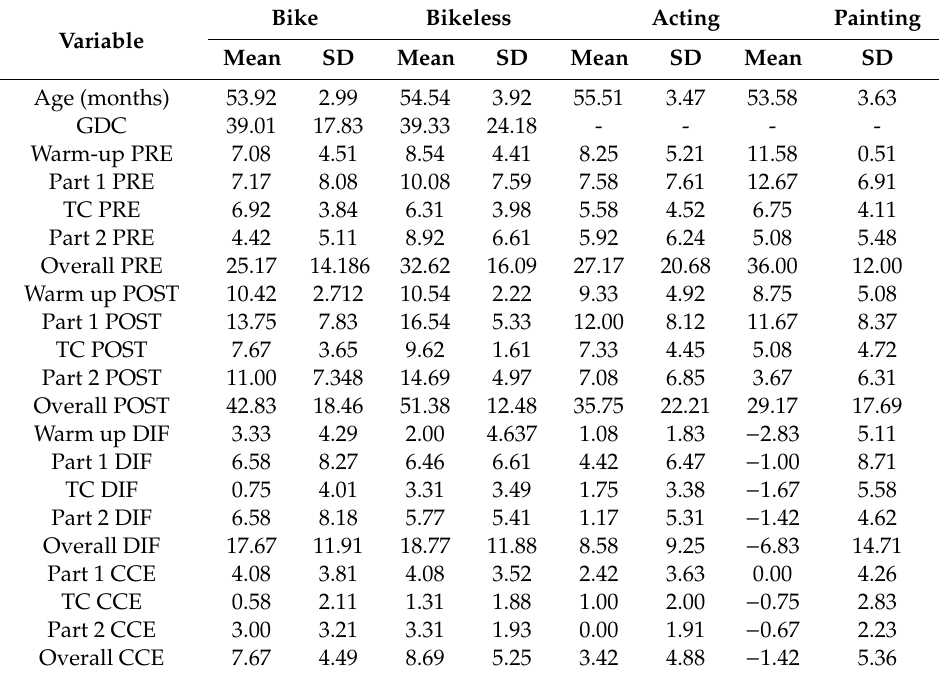
Table 2. Descriptive statistics for the variables of the